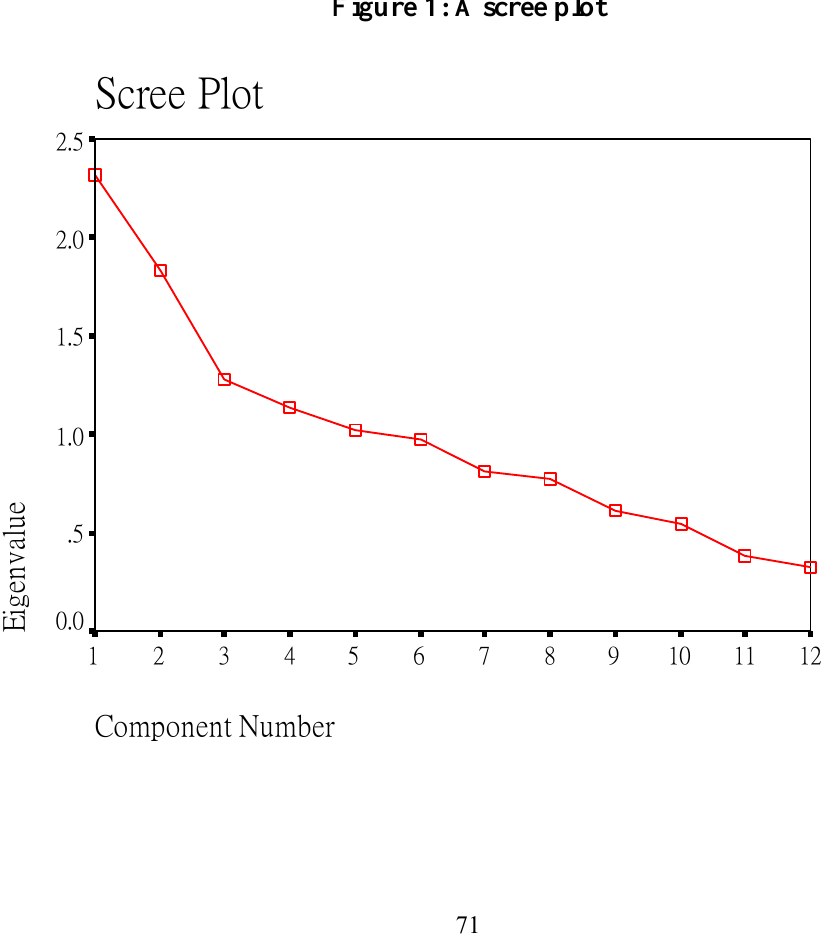
Figure 1: A scree